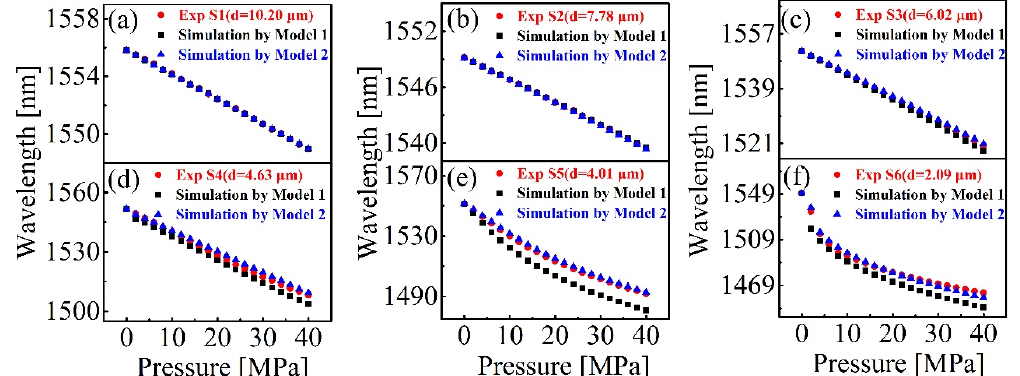
Figure 6. Schematics of the established geometric models: ( a ) Model 1 (i.e., plane silica diaphragm) and ( b ) Model 2 (i.e., cambered surface silica diaphragm with curvature radius R ). ( c ) Simulated deformation of the diaphragm under pressure.